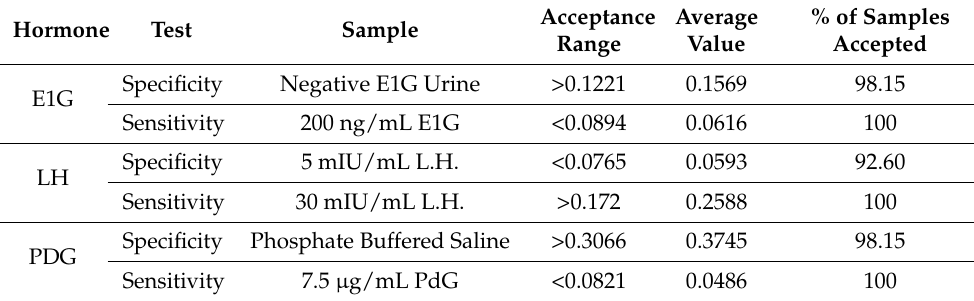
Table 1. Specificity and Sensitivity Testing.